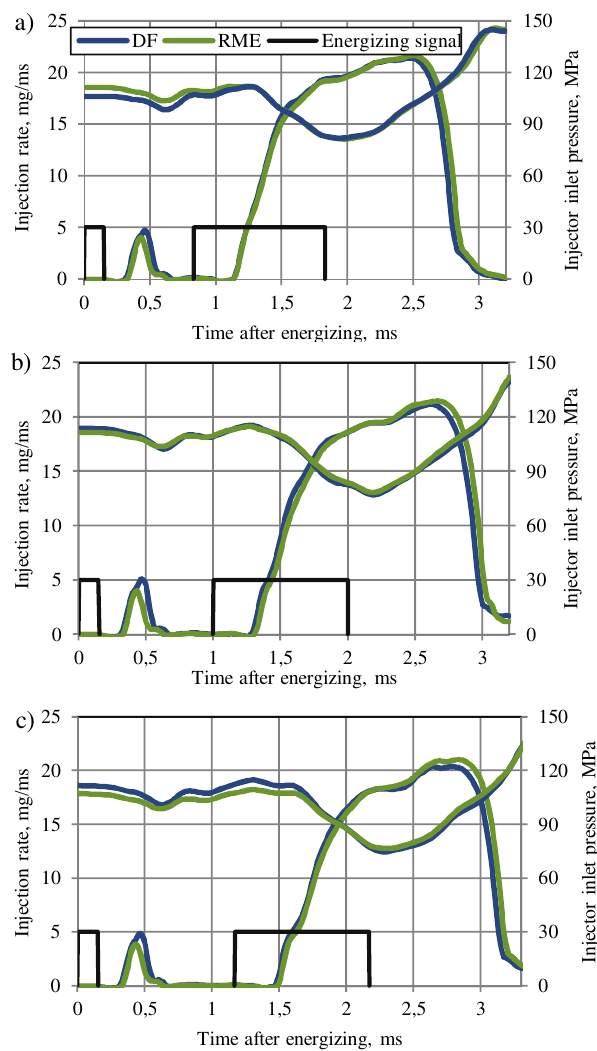
Fig. 2. Effects of pilot injection energizing pulse and split injection inter- val on the injector inlet pressure fluctuation and the injection rate of the fuels at the injection intervals: a – 0.8 ms, b – 1.0 ms, c – 1.2